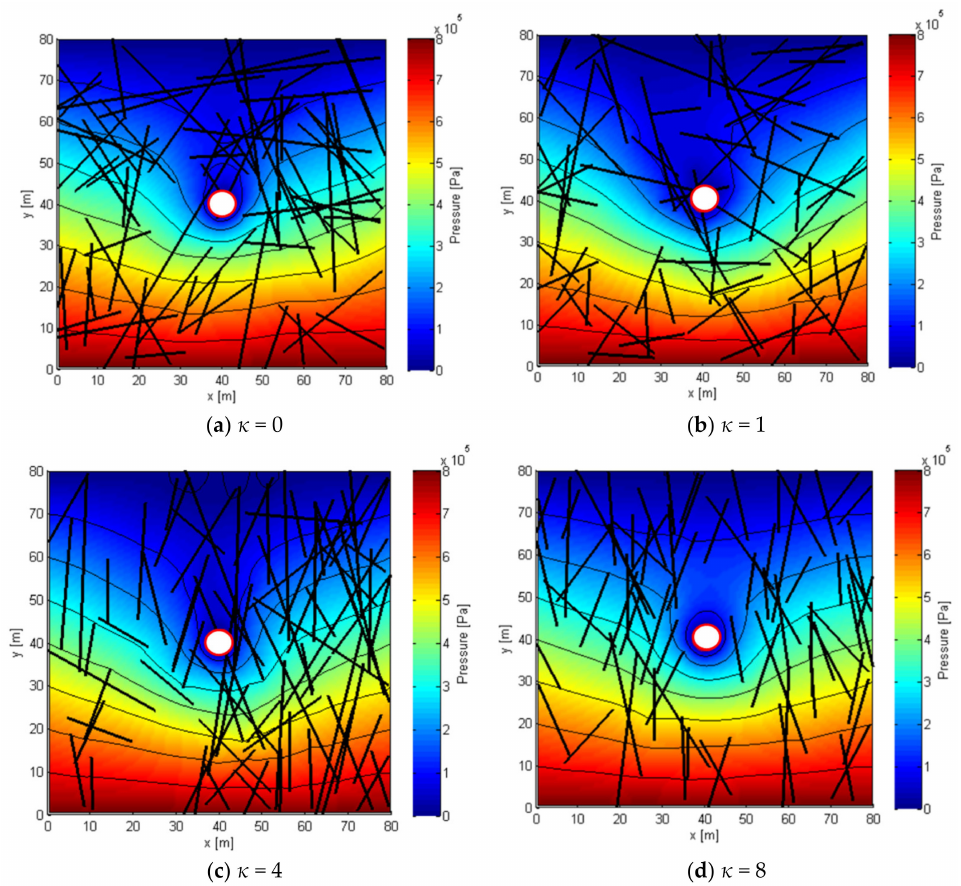
Figure 7. Water pressure distribution of fractured rock tunnel under different κ